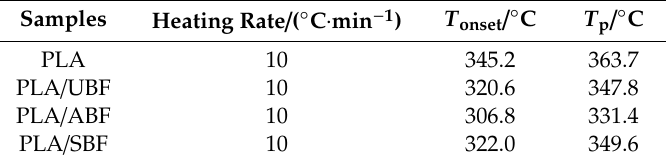
Table 6. Mass loss temperatures of BF / PLA composites with di ff erent modified BF.